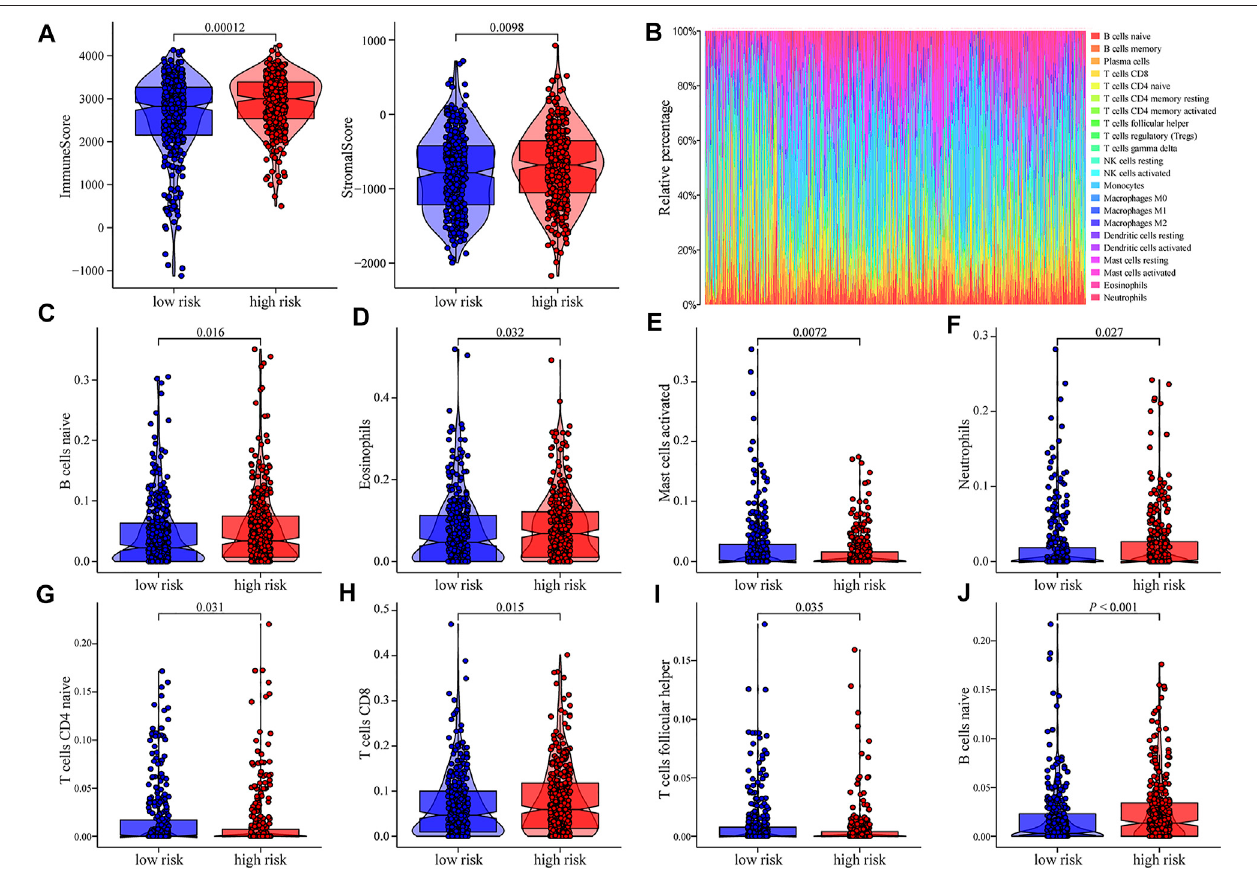
FIGURE 4 | Relationship between risk scores and distinct immune cell in fi ltration. (A) Scatter diagram indicating the immune-related scores, and matrix-related scores of high-risk patient group were signi fi cantly increased ( p < 0.05). (B) CIBERSORT was conducted to show the level of overall immune cell in fi ltration of AML patients in TCGA and GEO database. (C – J) Correlation analyses indicating that there were obvious differences in the expression of multiple immune cell subtypes between high- and low-risk groups of AML